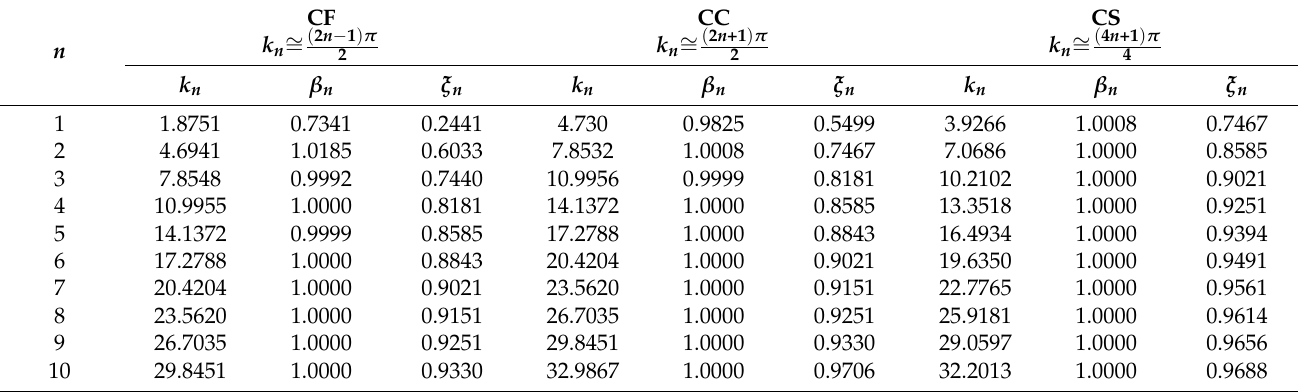
Table 2. Numerical values for k n , β n , and ξ n for different boundary conditions at different structural mode shapes.